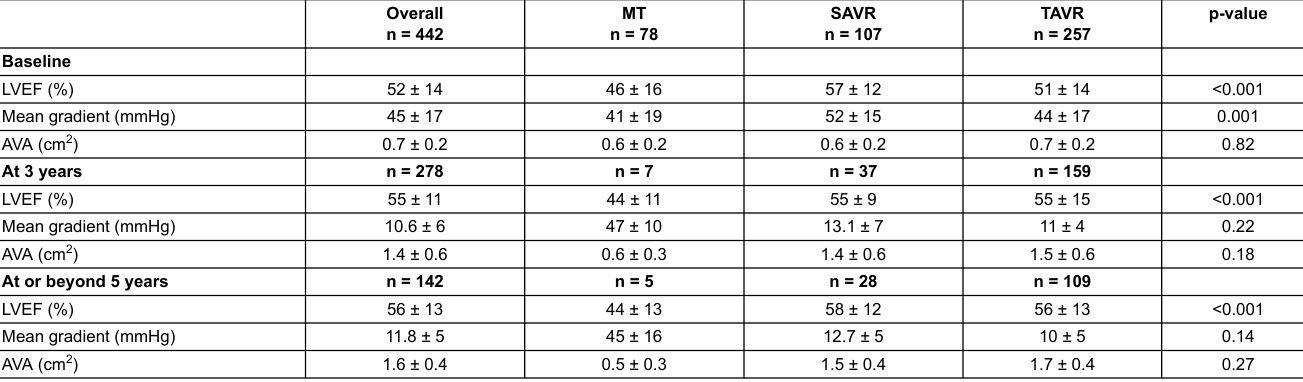
Table 2: Echocardiographic